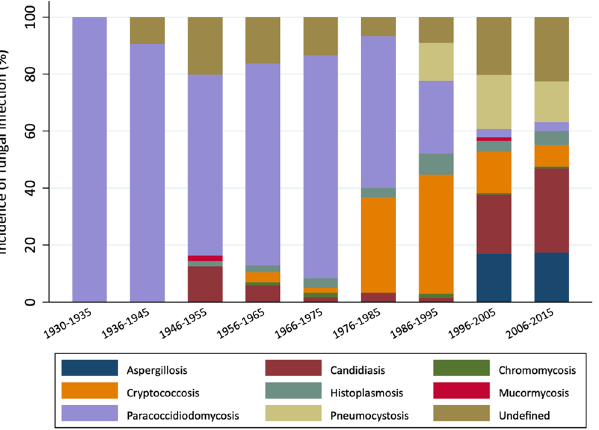
Figure 2. Proportional incidence of fungal infections by genus in autopsy reports between 1930 and